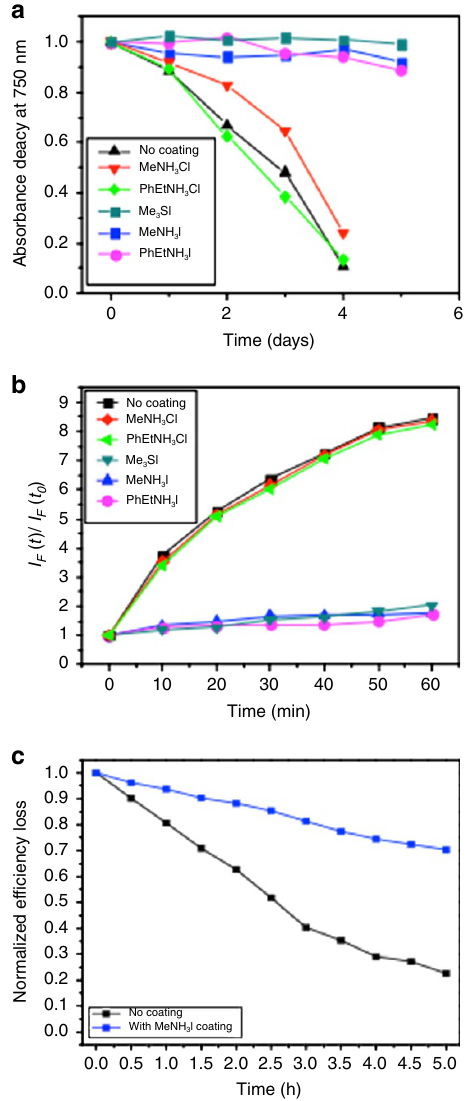
Figure 9 | Film passivation using salt additives. ( a ) Normalized absorbance decay at 750nm under illumination (25mWcm (cid:2) 2 ) and dry air flow for a pristine CH 3 NH 3 PbI 3 and CH 3 NH 3 PbI 3 coated with phenylethylammonium iodide (PhEtNH 3 I), methylammonium iodide (MeNH 3 I), trimethylsulfonium iodide (Me 3 SI), phenylethylammonium chloride (PhEtNH 3 Cl) and methylammonium chloride (MeNH 3 Cl) as described in the experimental section. ( b ) Superoxide yield plot